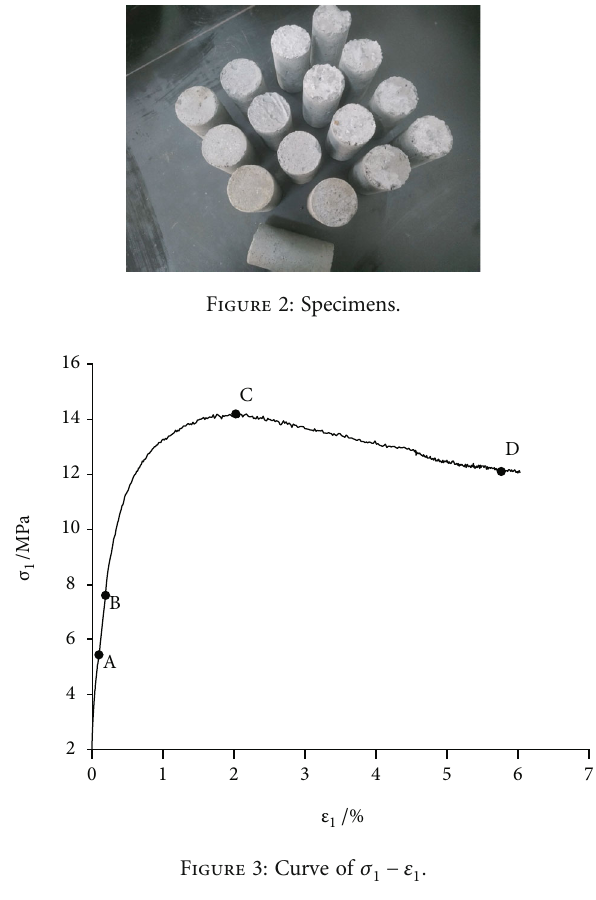
Figure 3: Curve of σ